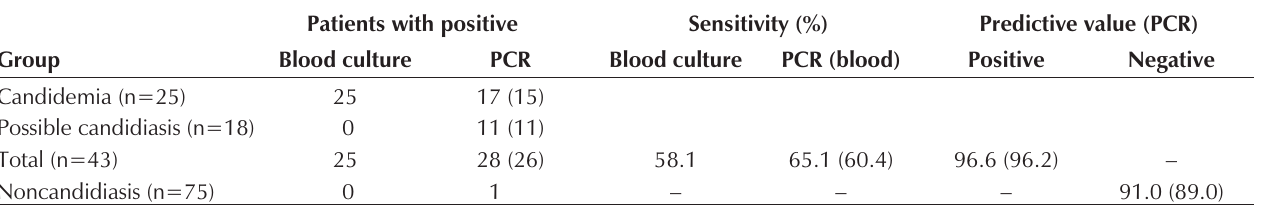
Detection of yeast by blood cultures and enzyme immunoassay-polymerase chain reaction (PCR) (gel electrophoresis) in patients with invasive candidiasis, and sensitivity and specificity of test methods Patients with